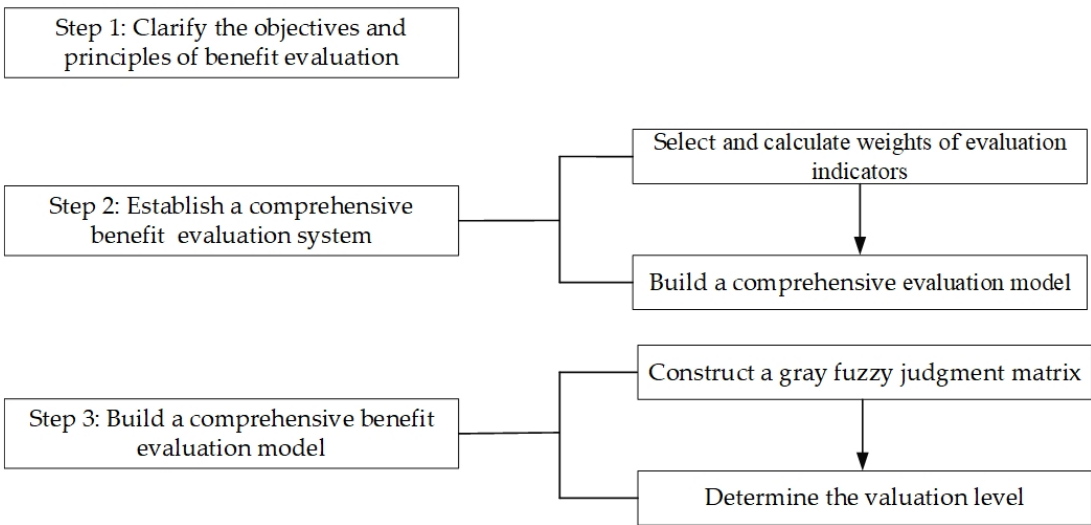
Figure 1. The steps involved in developing the comprehensive benefit evaluation system for pervious pavements.